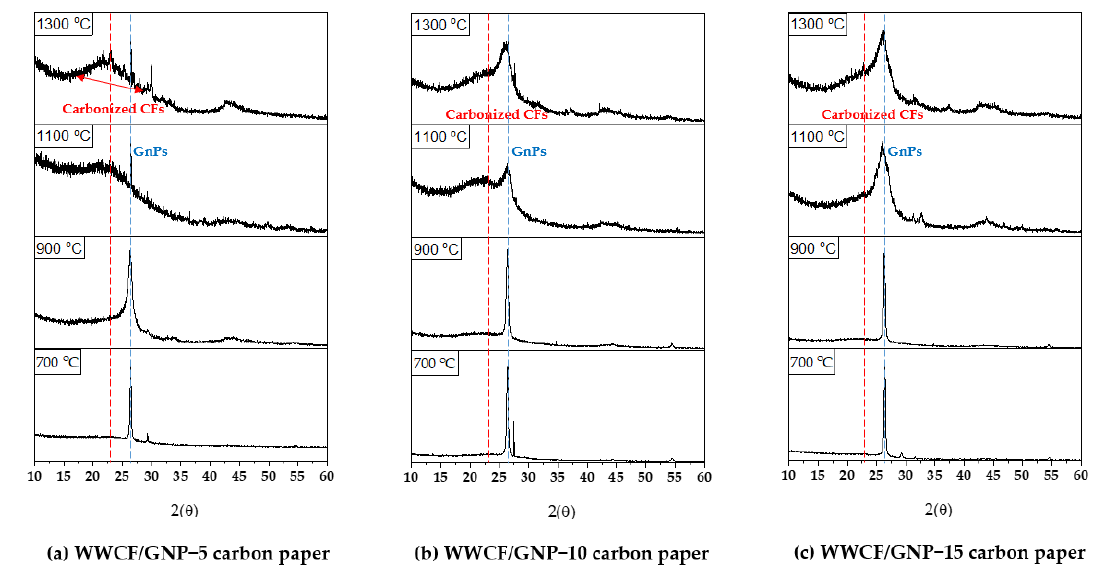
Figure 3. X-ray diffraction (XRD) patterns of waste wood cellulose fiber/graphene nanoplatelet (WWCF/GnP) carbon papers.